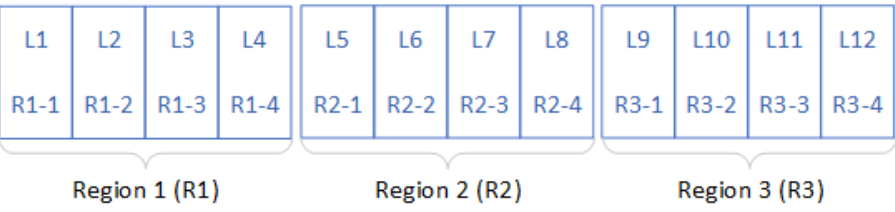
Figure 1. The twelve layers (L1 to L12) of the BERT BASE model are partitioned into 3 regions. R n - i represents the i th layer in the n th